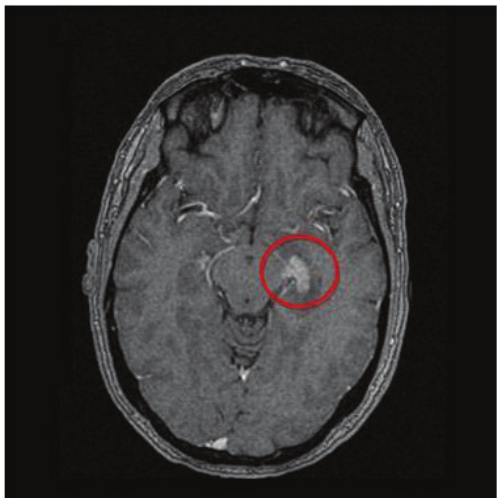
Figure 2: PET scan revealed a well-delimited lesion in the left temporal region that suggested